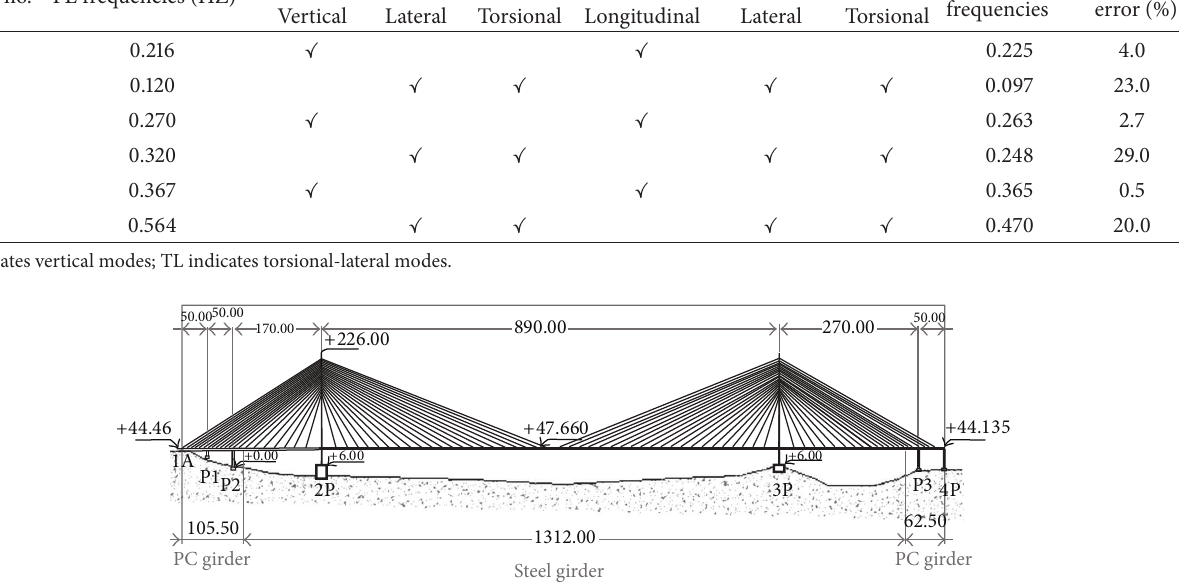
Table 2: Comparison of natural frequencies (Hz) between field tests and FE modeling. Mode no. FE frequencies (HZ)